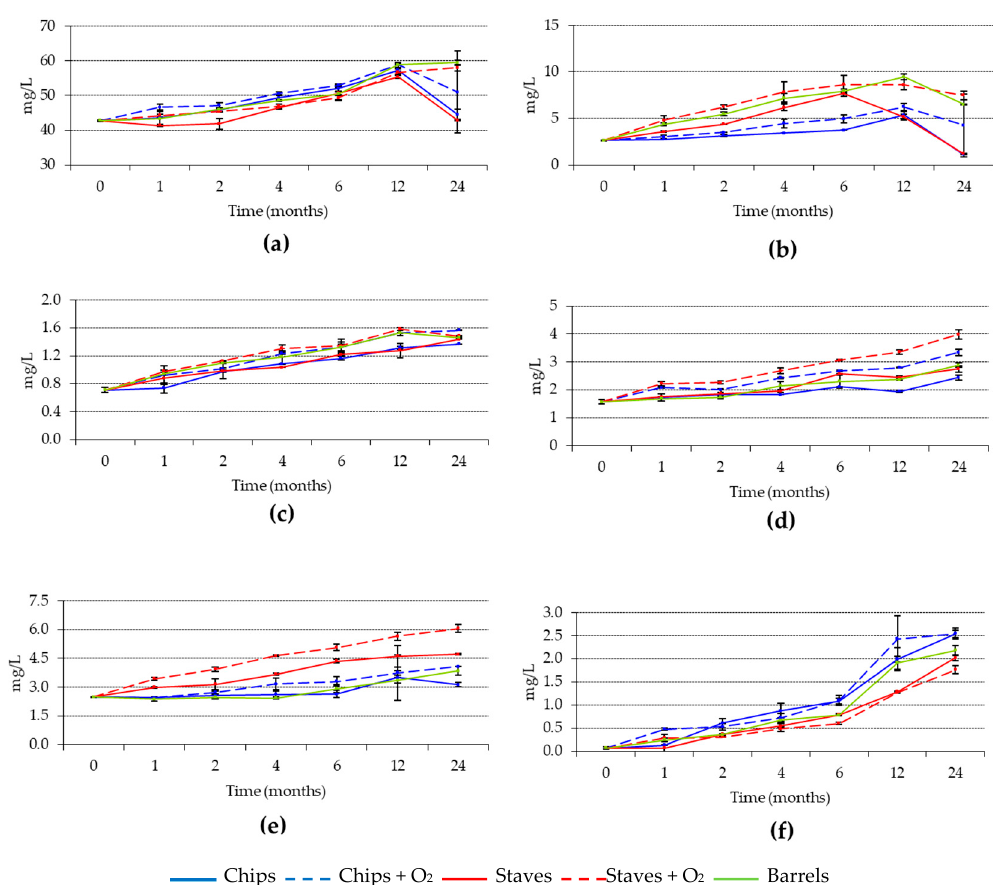
Figure 5. Evolution of benzoic acids concentration (mg/L) over time: ( a ) gallic acid; ( b ) protocatechuic acid; ( c ) p-hydroxybenzoic acid; ( d ) vanillic acid; ( e ) syringic acid; and ( f ) ellagic acid. Mean ± standard deviation ( n = 2).